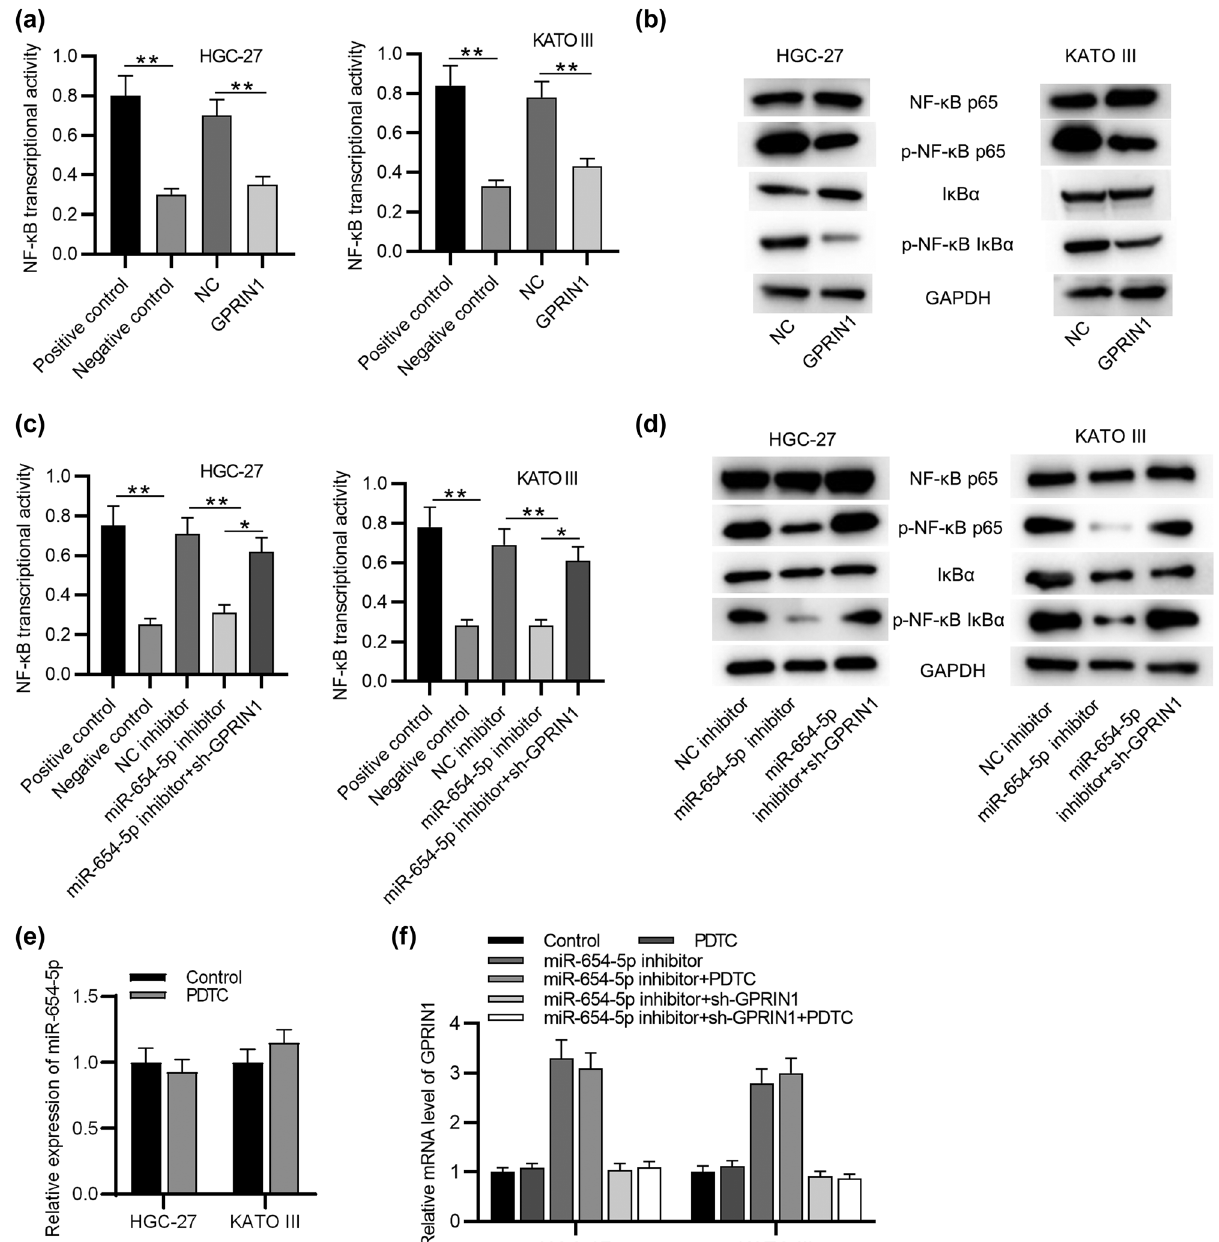
Figure 5: miR - 654 - 5p modulates the NF - κ B pathway by GPRIN1. ( a ) NF - κ B transcriptional activity was measured in HGC - 27 and KATO III cells after GPRIN1 overexpression. ( b ) HGC - 27 and KATO III cells were transfected with pcDNA3.1/GPRIN1 and empty pcDNA3.1. Protein levels of NF - κ B p65, p - NF - κ B p65, I κ B α , and p - NF - κ B I κ B α in HGC - 27 and KATO III cells were examined by Western blotting. ( c ) NF - κ B transcriptional activity in HGC - 27 and KATO III cells co - transfected with miR - 654 - 5p inhibitor and sh - GPRIN1 was measured. ( d ) GC cells were co - trans - fected with miR - 654 - 5p inhibitor and sh - GPRIN1 and corresponding controls. Protein levels of NF - κ B p65, p - NF - κ B p65, I κ B α , and p - NF - κ B I κ B α were detected by Western blotting. ( e ) In fl uence of PDTC on relative expression of miR - 654 - 5p was detected by RT - qPCR. ( f ) Relative expression of GPRIN1 in the control, PDTC, miR - 654 - 5p inhibitor, miR - 654 - 5p inhibitor + PDTC, miR - 654 - 5p inhibitor + sh - GPRIN1, and miR - 654 - 5p inhibitor + sh - GPRIN1 + PDTC groups was detected by RT - qPCR. * p < 0.05, ** p <